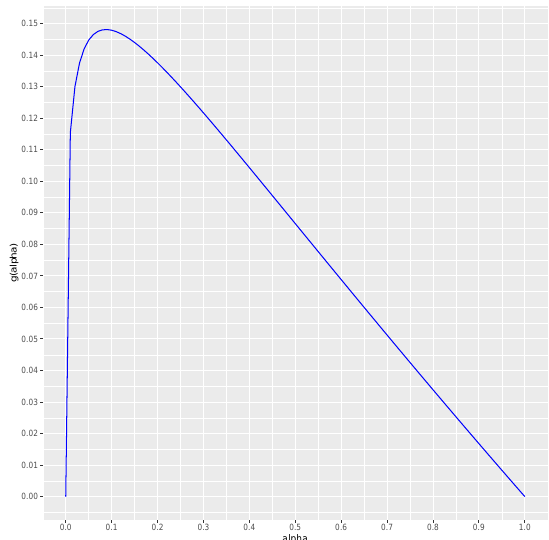
Figure 4.1: g ( α ) = F −1 3:3 ( α ) − F −1 2:2 ( α ) for α ∈ [0, 1]